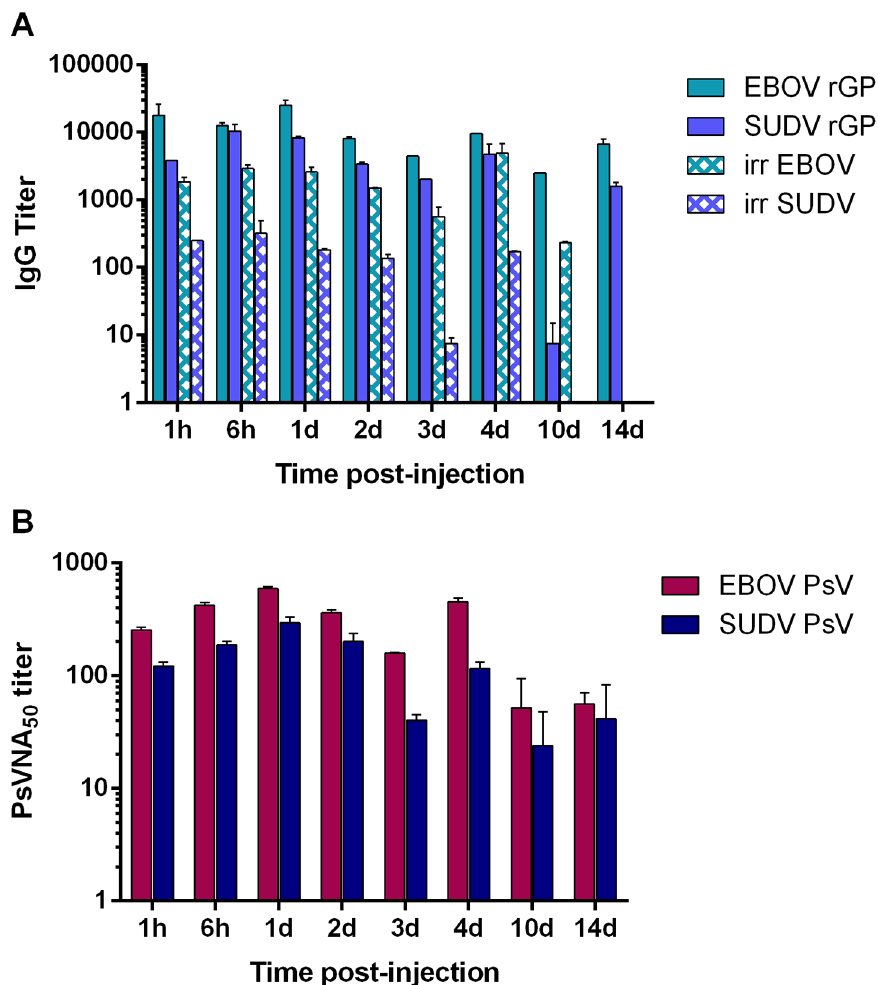
Fig 3. Bioavailability of purified EBOV/SUDV human pAbs in mice. BALB/c mice (N = 10) received a single IP injection of 100 mg/kg of the purified V3 EBOV/SUDV human pAbs. (A) Sera collected from individual mice at the indicated time points after injection were analyzed by standard ELISA for total human IgG using whole-irradiated EBOV or SUDV antigen, and EBOV rGP or SUDV rGP antigen. (B) Serum samples were also evaluated for EBOV- and SUDV-neutralizing activity by